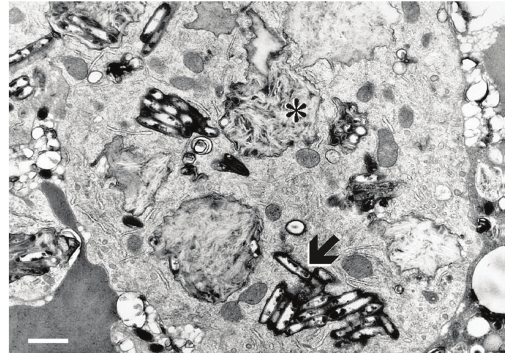
Figure 17: Groups of microbes (arrow) and characteristic lysosomes (asterisk) present in an intestinal histiocyte in Whipple’s disease. Electron micrograph, scale = 2 𝜇 m. Courtesy of Professor Josef ˇSpaˇcek, MD, DSc. Reproduced with permission from Bureˇs and Rejchrt [42].